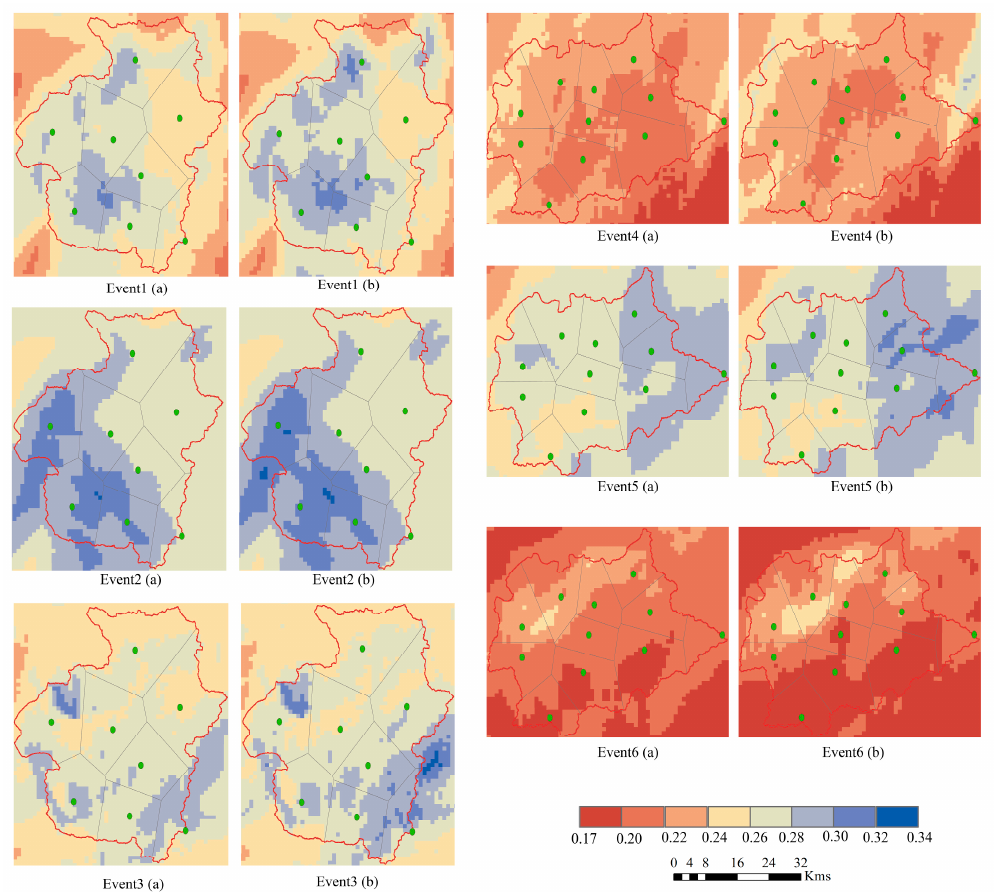
Figure 12. Spatial distributions of the hourly averaged soil moisture of the four soil layers: ( a ) WRF-only; ( b ) the fully coupled WRF/WRF-Hydro.